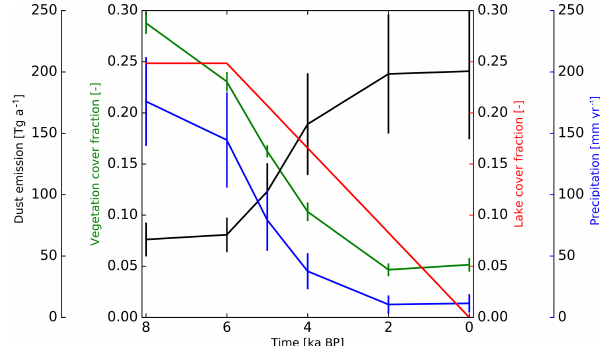
Figure 8. Simulated dust emissions (black), vegetation cover frac- tion (green), lake cover fraction (red) and precipitation (blue) aver- aged over the western Sahara (15 ◦ W–2 ◦ E, 18–29 ◦